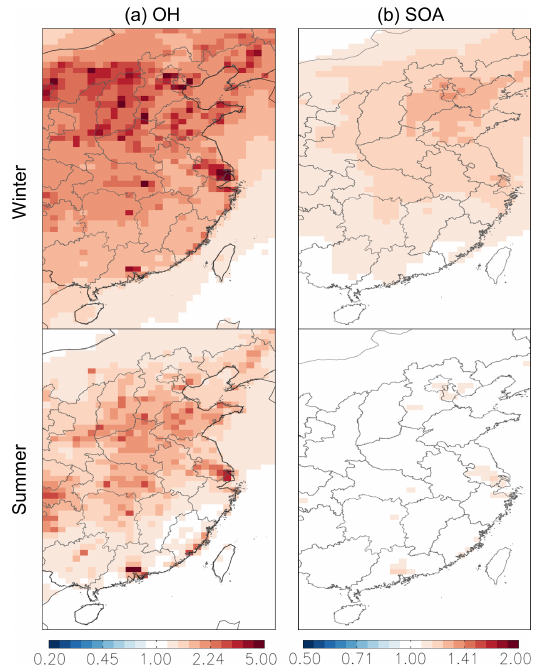
Figure 2. The ratios of seasonal mean concentrations of (a) OH and (b) SOA simulated by the Sp_R1 + 2 simulation to those simulated by the Sp_R1